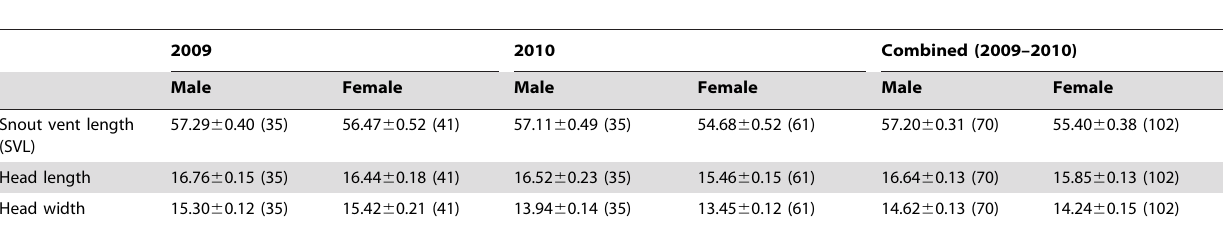
Table 1. Mean 6 SE (N) snout-vent length (mm), head length (mm) and head width (mm) of male and female P. vlangalii captured in 2009 and 2010 in Xiamen Nature Reserve.